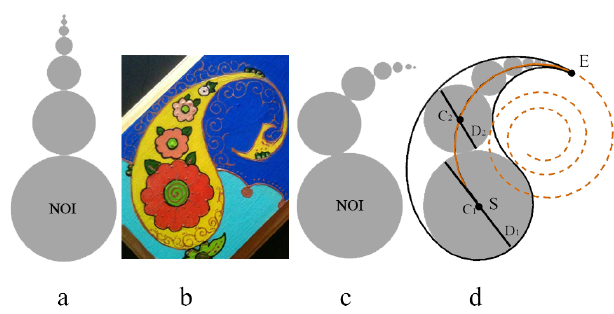
Figure 3. (a) Shrinking ancestral chain. (b) A traditional Paisley pattern. (c) The ancestral chain arranged on a spiral curve. (d) The node circles filling the Paisley